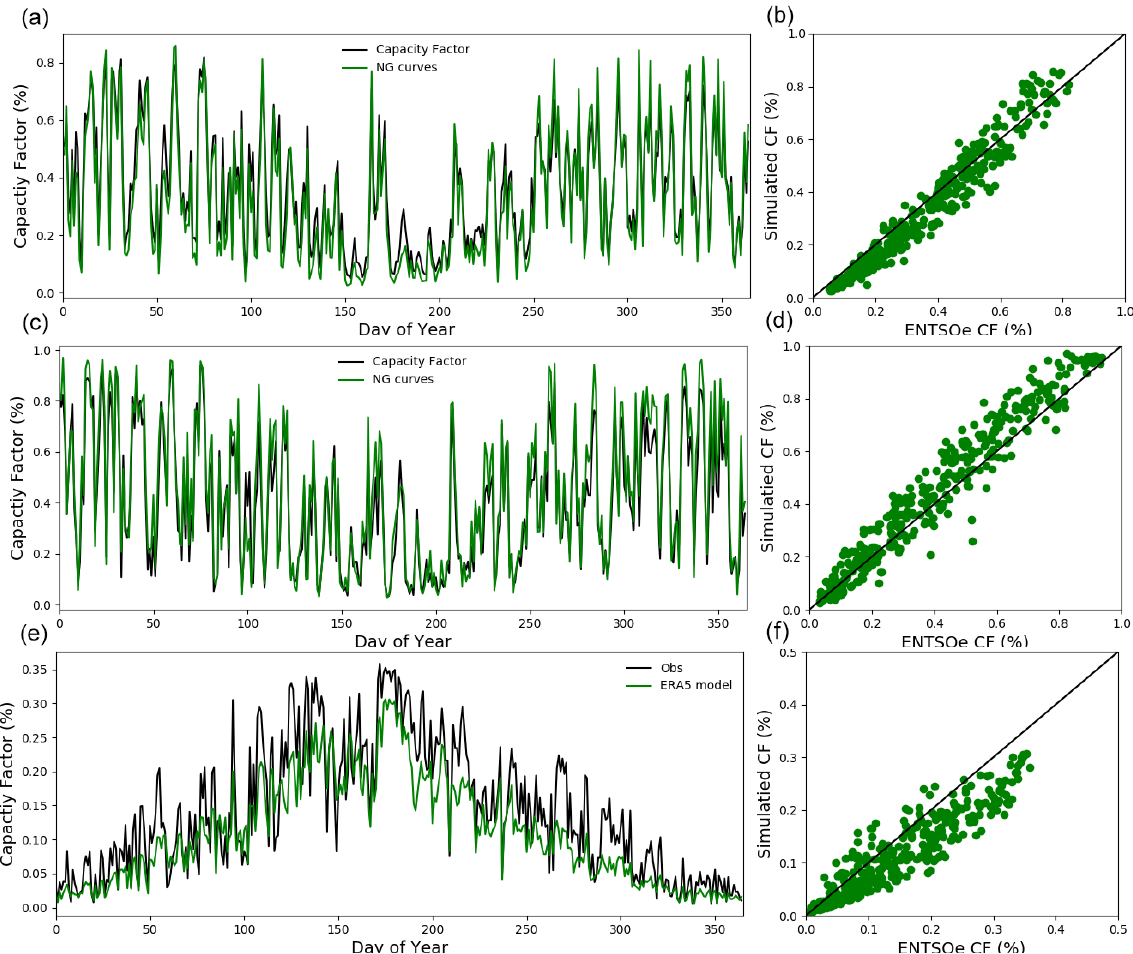
Figure A3. Example verification of the wind and solar PV models for (top) onshore wind, (middle) offshore wind, and (bottom) solar PV. For the wind power model, validation data (black) are taken from the ELEXON data portal, and for the solar PV data they are taken from ENTSO-E (ENTSO-E,